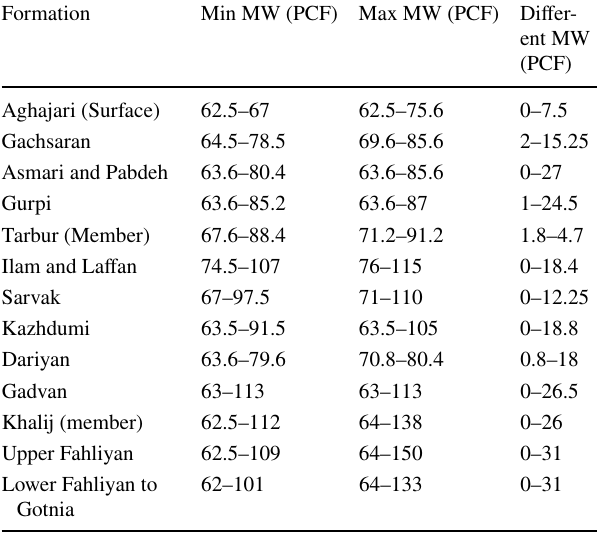
Fig. 13 Diagram of a minimum, b maximum values and changes in mud weight (PCF) based on increasing the depth of the studied field Table 10 Variations in minimum and maximum mud weight (drill- ing mud window) based on pore and fracture pressures of the South Azadegan Formation